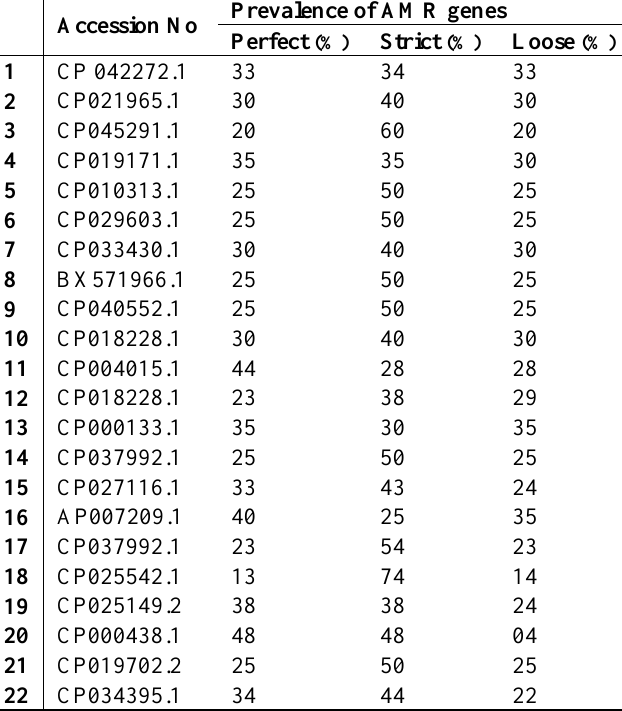
Table 1. Prevalence of AMR gene family among